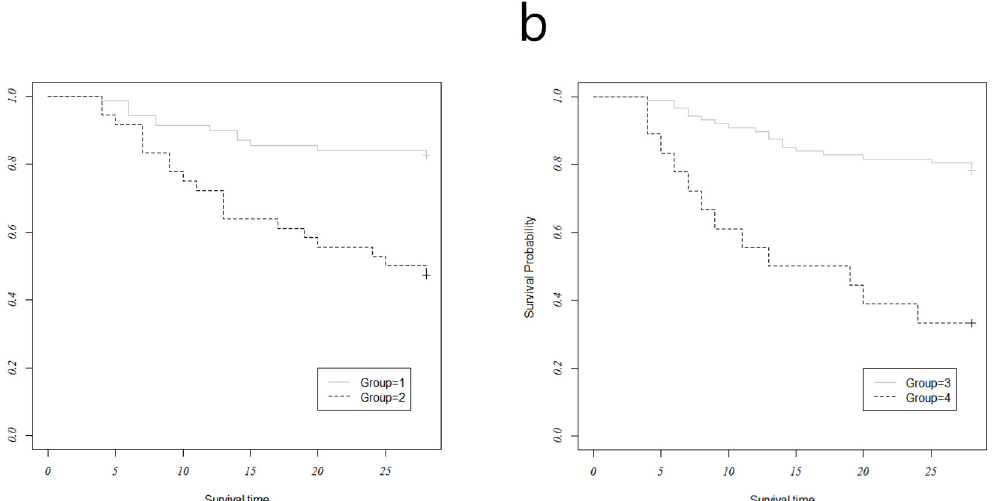
Fig 2. (a) Kaplan-Meier 28-day survival analyses comparing groups 1 (PCTc (cid:1) 78%) and 2 (PCTc < 78%). Solid line, group 1; dotted line, group 2; p = 0.001 based on log-rank tests. (b) Kaplan-Meier 28-day survival analyses comparing groups 3 (CRPc (cid:1) 36%) and 4 (PCTc < 36%). Solid line, group 3; dotted line, group 4; p < 0.001 based on log-rank